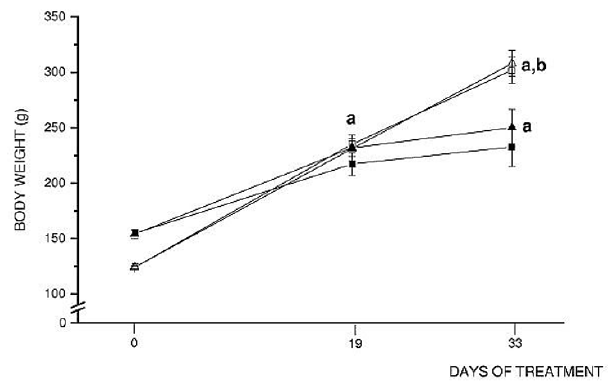
Body weight of normal and streptozotocin-diabetic rats dur-ing extended treatment with Bauhinia forficata